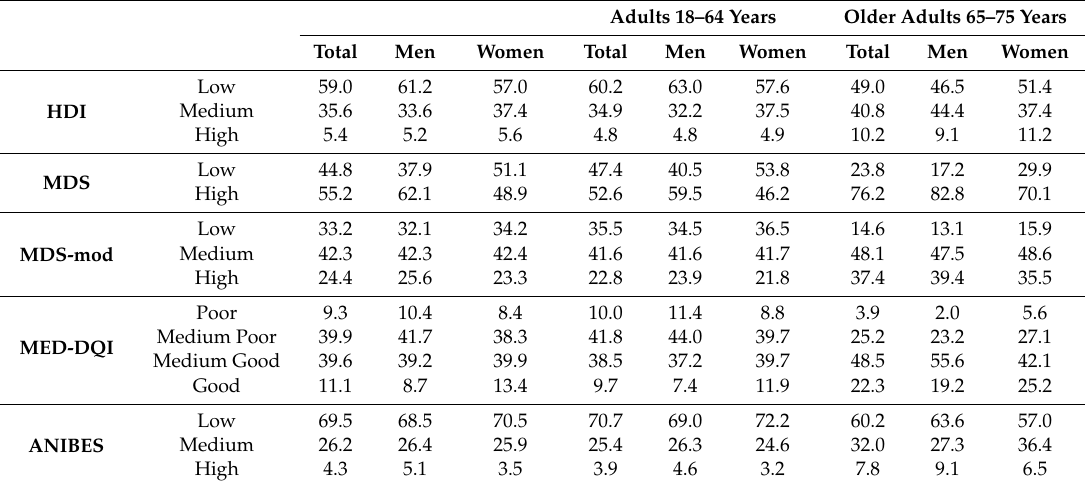
Table 4. Percentage of the ANIBES population according to diet quality indexes (DQIs), classified by cut-o ff values in adults and older adults and stratified by